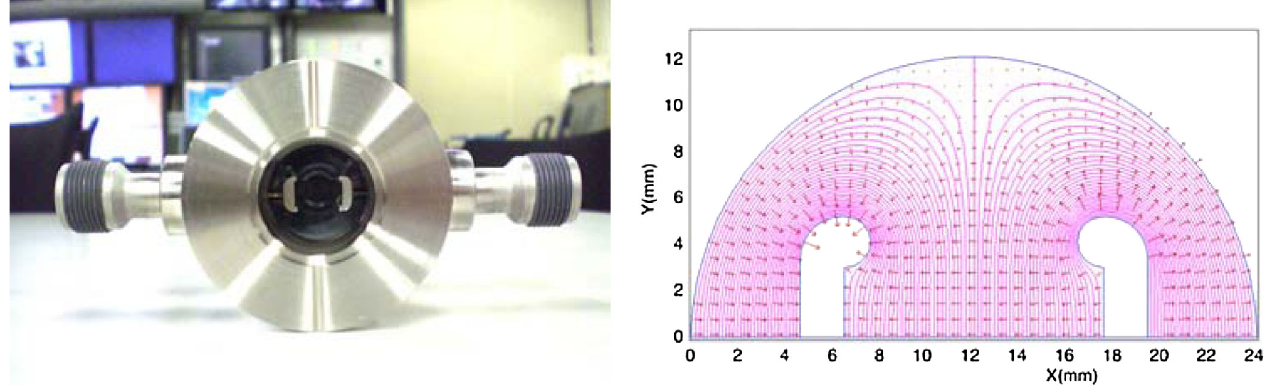
FIG. 7. Photograph of the strip-line electrode and diagram of the simulated electric and magnetic field.